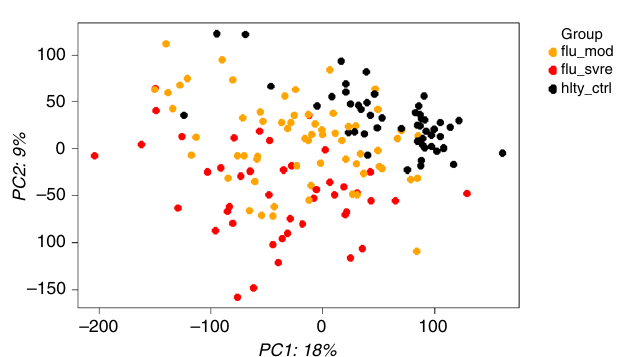
Fig. 2 Principal component analysis (PCA). Unsupervised principal component analysis was performed across all samples (including healthy controls, moderate, and severe groups) using normalized log 2 gene- expression levels. Based on two principal components (PC1 and PC2), moderate in fl uenza (yellow data points) and severe in fl uenza (red data points) showed evidence of separation in gene-expression space. The source data are available in Gene Expression Omnibus (GSE